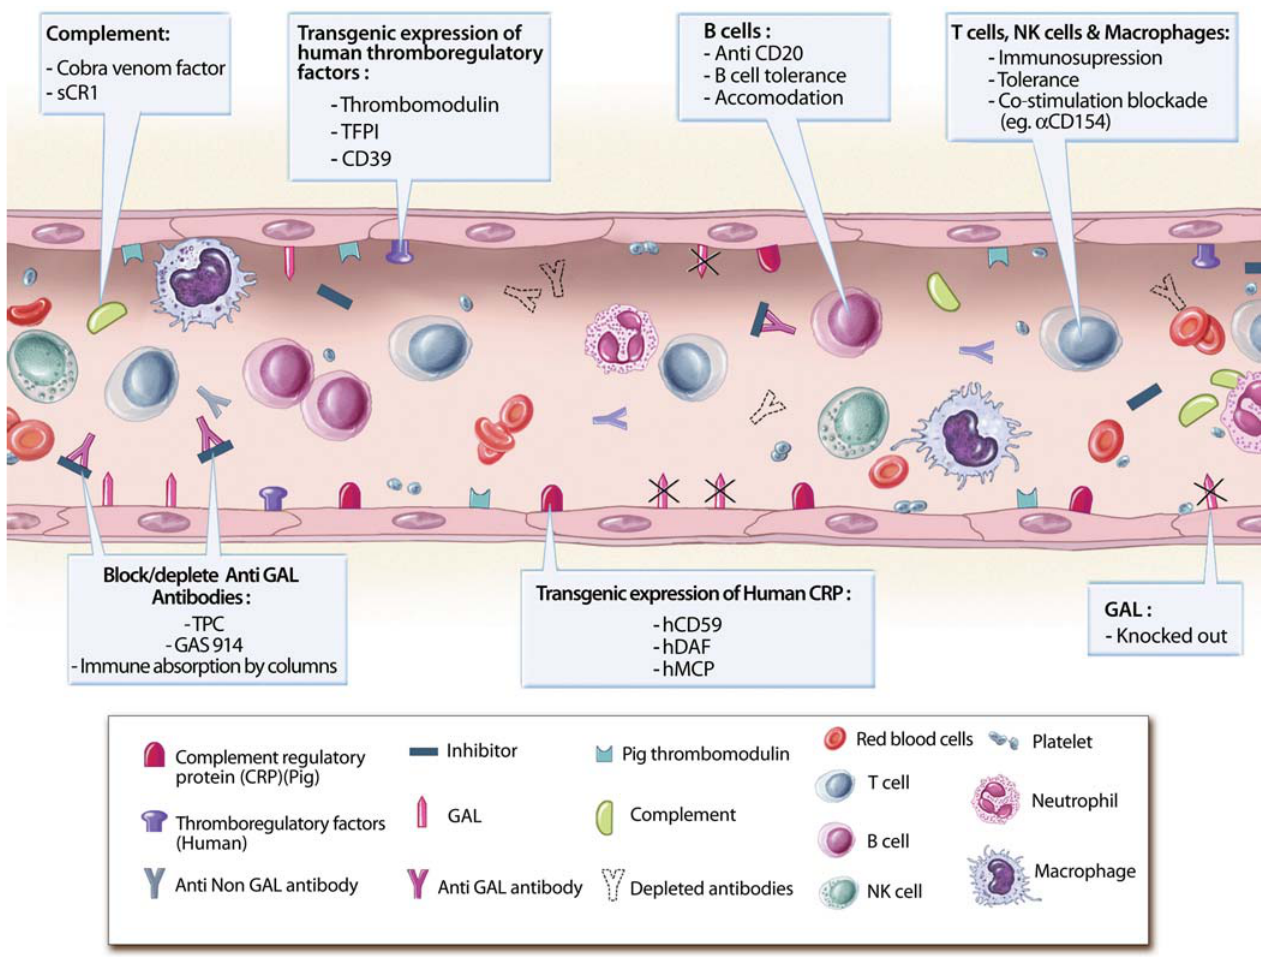
Figure 1. Current Methods to Prevent Xenograft Rejection TFPI, tissue factor pathway